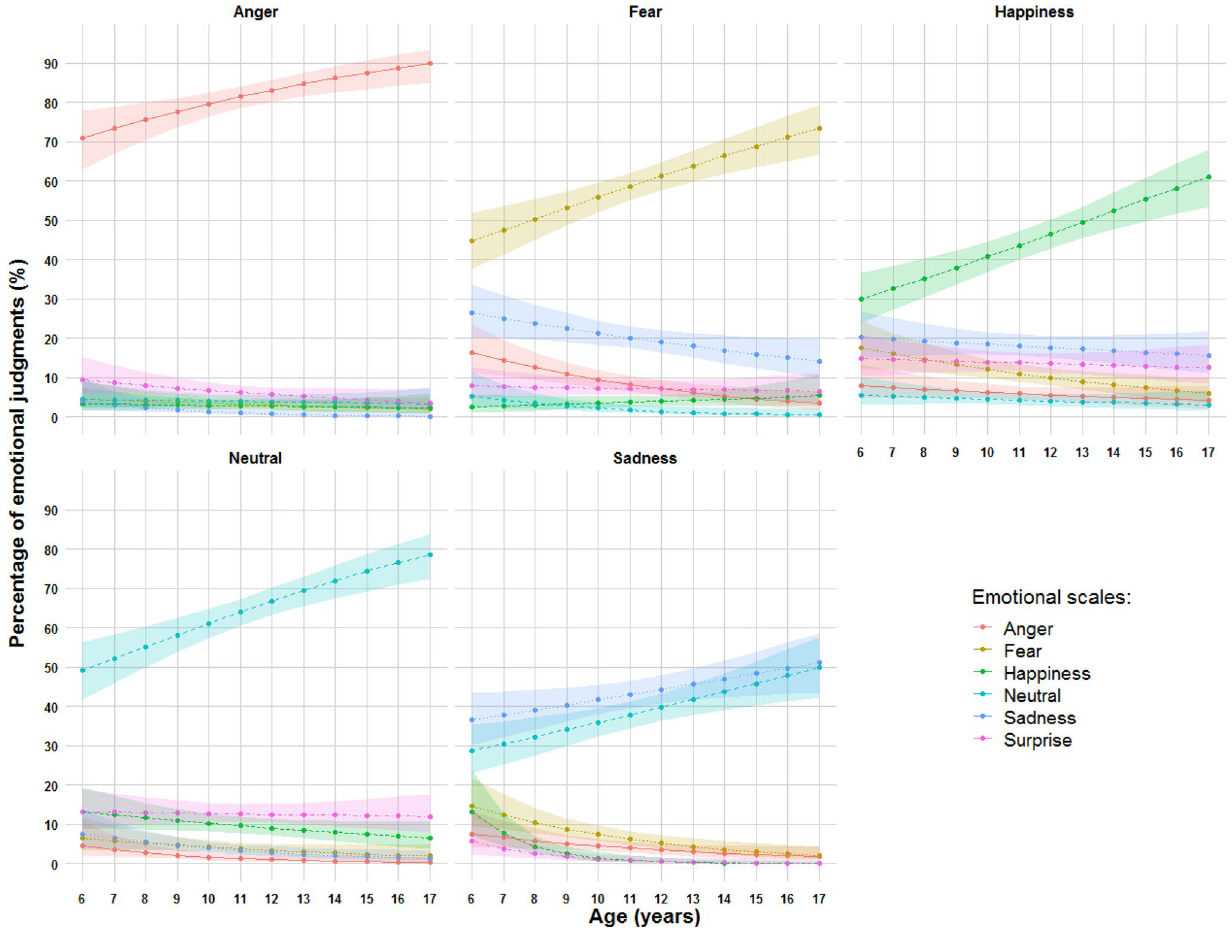
Figure 1. Percentages of emotion judgments as a function of age. Shaded areas represent 95% confidence intervals. The percentage of correct responses homogeneously increased with